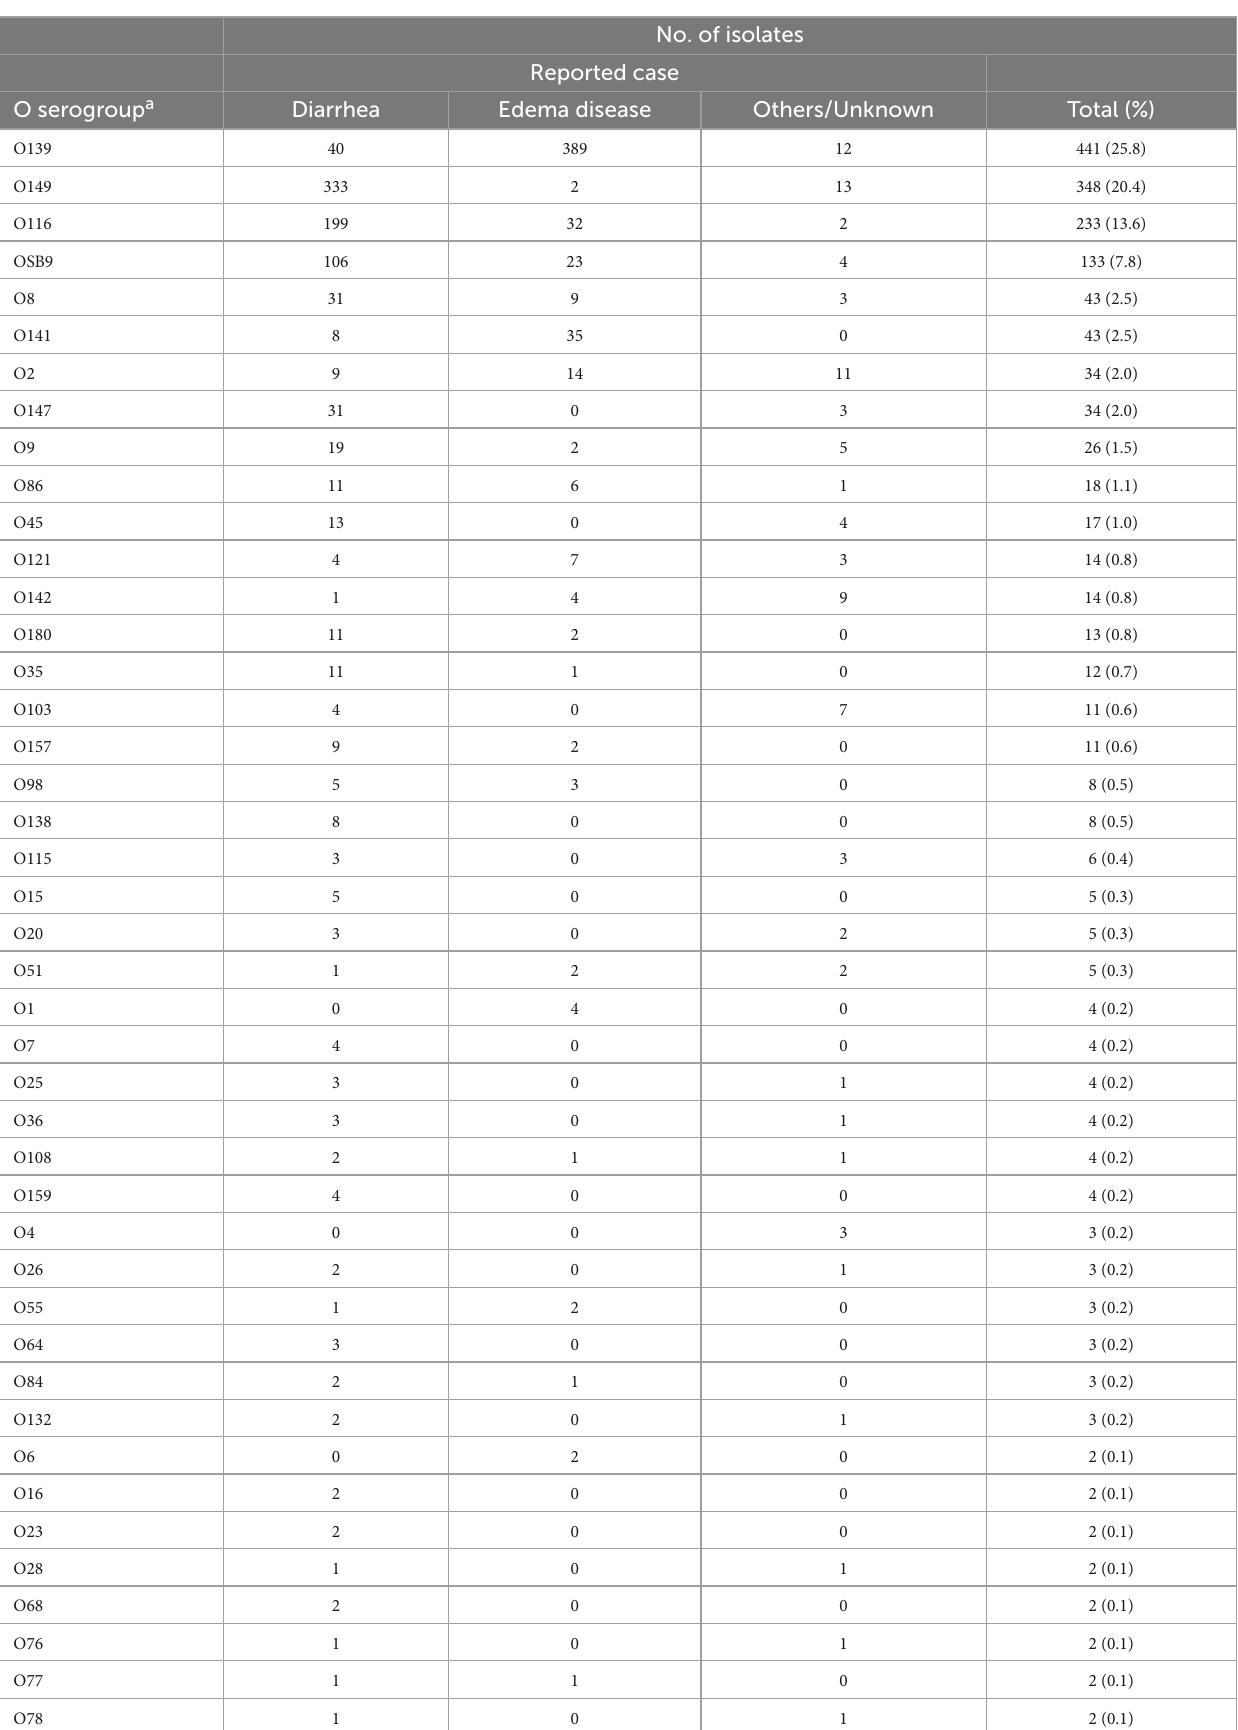
TABLE 1 Serogroups of E. coli isolates from swine in Japan between 1991 and 2019.